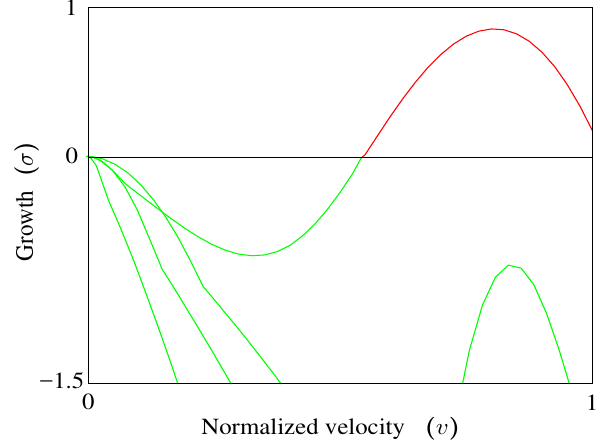
Figure 4. Process 1: V - σ - ω analysis with η 0 = 0 (Green means stable, red means